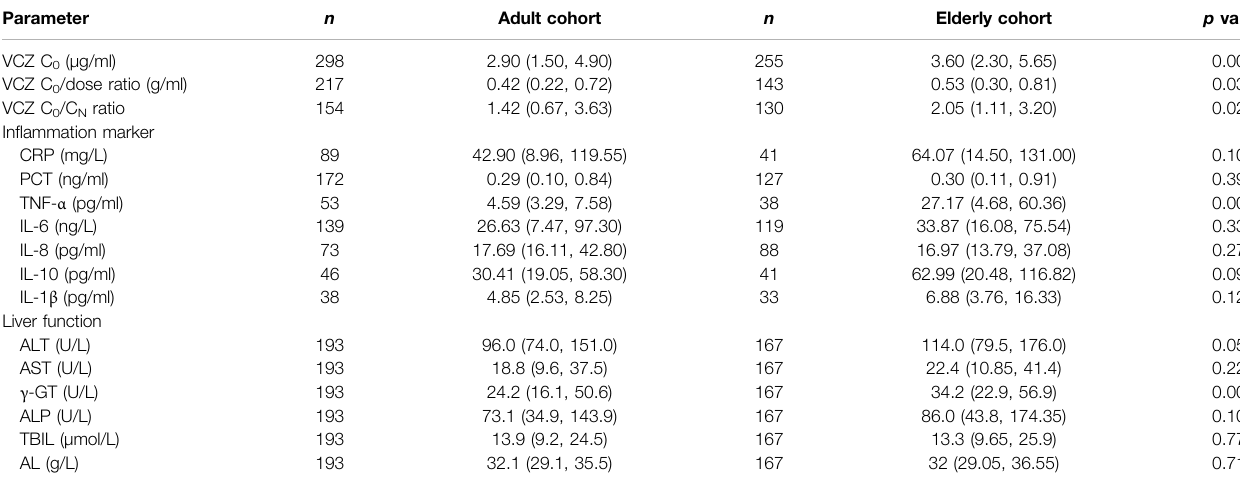
TABLE 2 | Laboratory parameters of patients in the two cohorts. Parameter